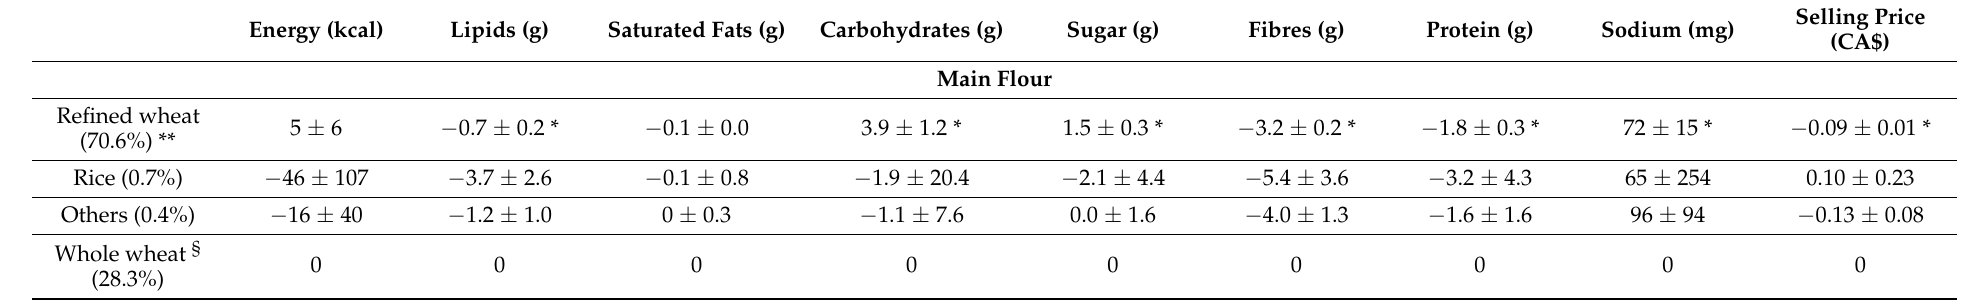
Table 4. Multivariate analyses of the nutritional value and price per serving of bread purchased, based on the main